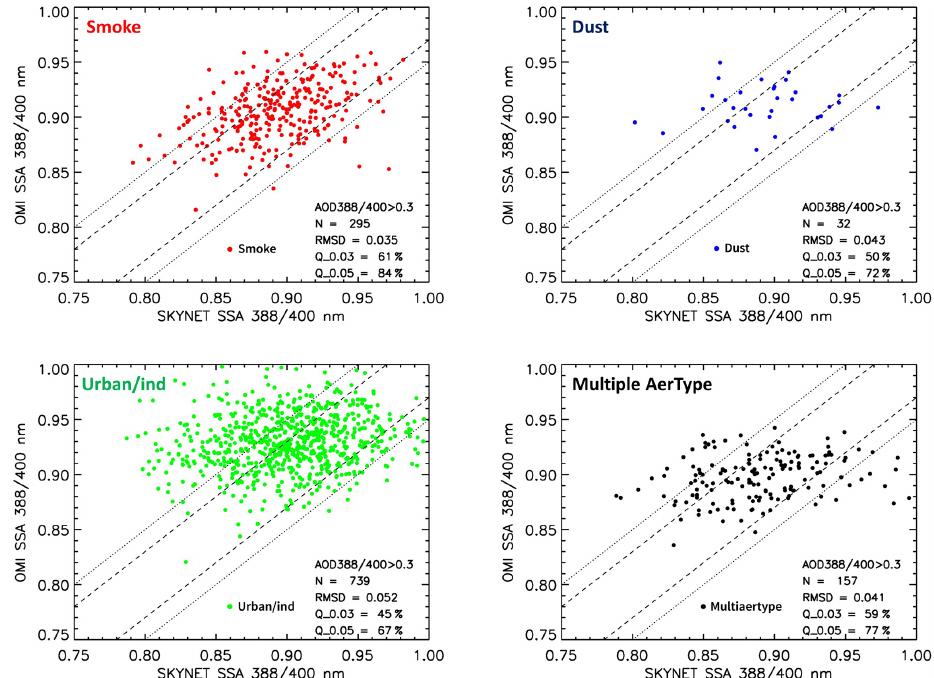
Figure 4. Composite scatterplots of OMAERUV versus SKYNET single-scattering albedo (388 or 400nm) for the three distinct aerosol types, i.e., smoke, dust, and urban/industrial, as identified by the OMAERUV algorithm. OMI–SKYNET matchups with AOD>0.3 (388 or 400nm) in both measurements are used for the comparison. The matchup points labeled “multiaertype” represent conditions when collocated OMI pixels are identified with more than one aerosol